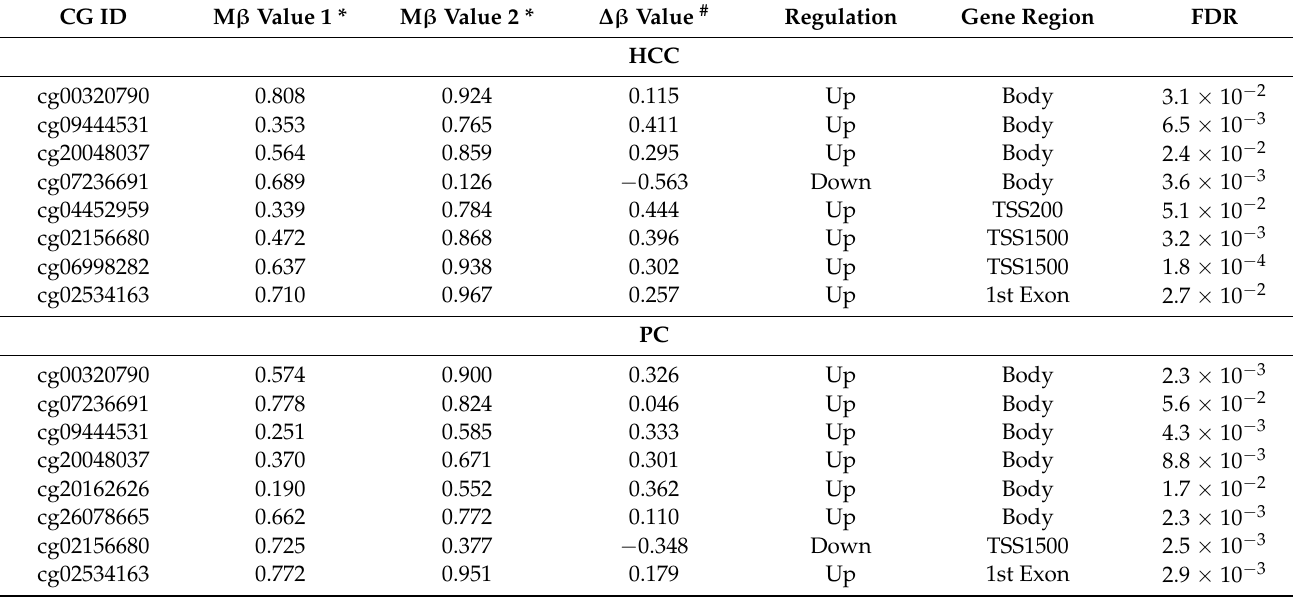
* Mean β (M β ) value 1 represents methylation in less invasive cell lines and * Mean β (M β ) value 2 methylation in more invasive; # ∆ β value: (Mean β value 2-Mean β value 1). Abbreviations: PC: Prostate Cancer, HCC: Hepatocellular Carcinoma, PA: Promoter Associated, TSS: Transcription Start